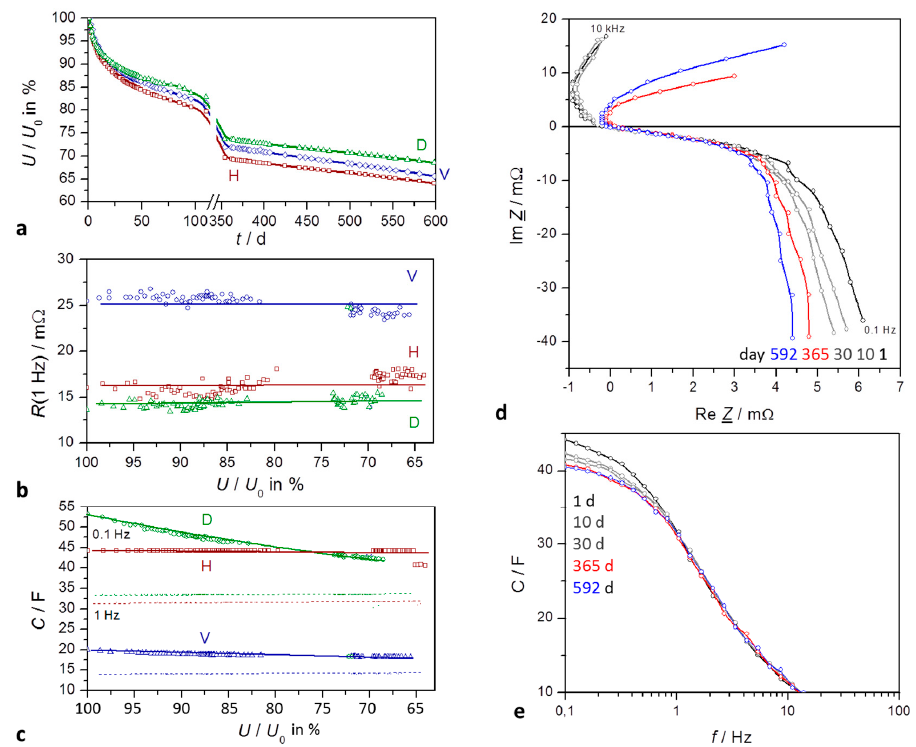
Figure 2. Self-discharge of supercapacitors for a time period of about 600 days: H VINA Hy-Cap, 2.7 V, 50 F; D VINA Hy-Cap, 3 V, 50 V; V Vitzrocell 2.7 F, 25 F. ( a ) State-of-charge (SoC) versus time (in days) emphaszising the early exponential decay and the late linear behavior; ( b ) Internal resistance at 1 Hz as measured, without correction of cable resistances; ( c ) Capacitance at 0.1 Hz (solid) and 1 Hz (dashed); ( d ) Impedance spectra in the complex plane, corrected by the contact and electrolyte resistance R e ; mathematical convention; ( e ) frequency response of capacitance during self-discharge.